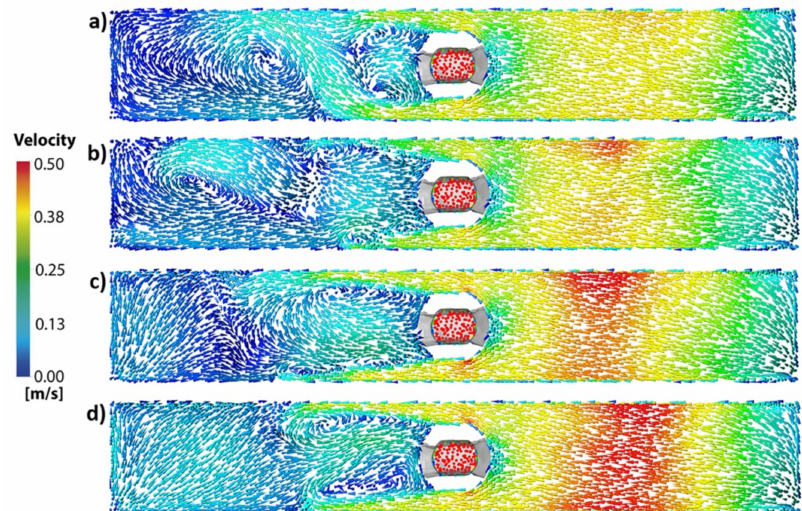
Figure 24. Velocity fields at the sub-surface (20 mm below the free surface) using nozzle B with clogging at different times. ( a ) 50 s. ( b ) 100 s. ( c ) 150 s. ( d ) 200 s.